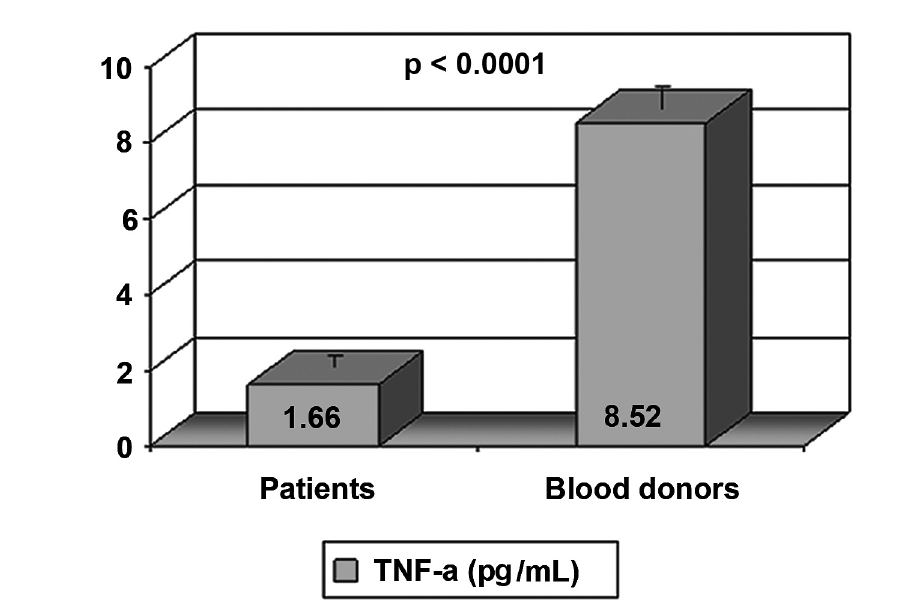
Figure 4 – TNF-α serum levels in PD patients and healthy blood